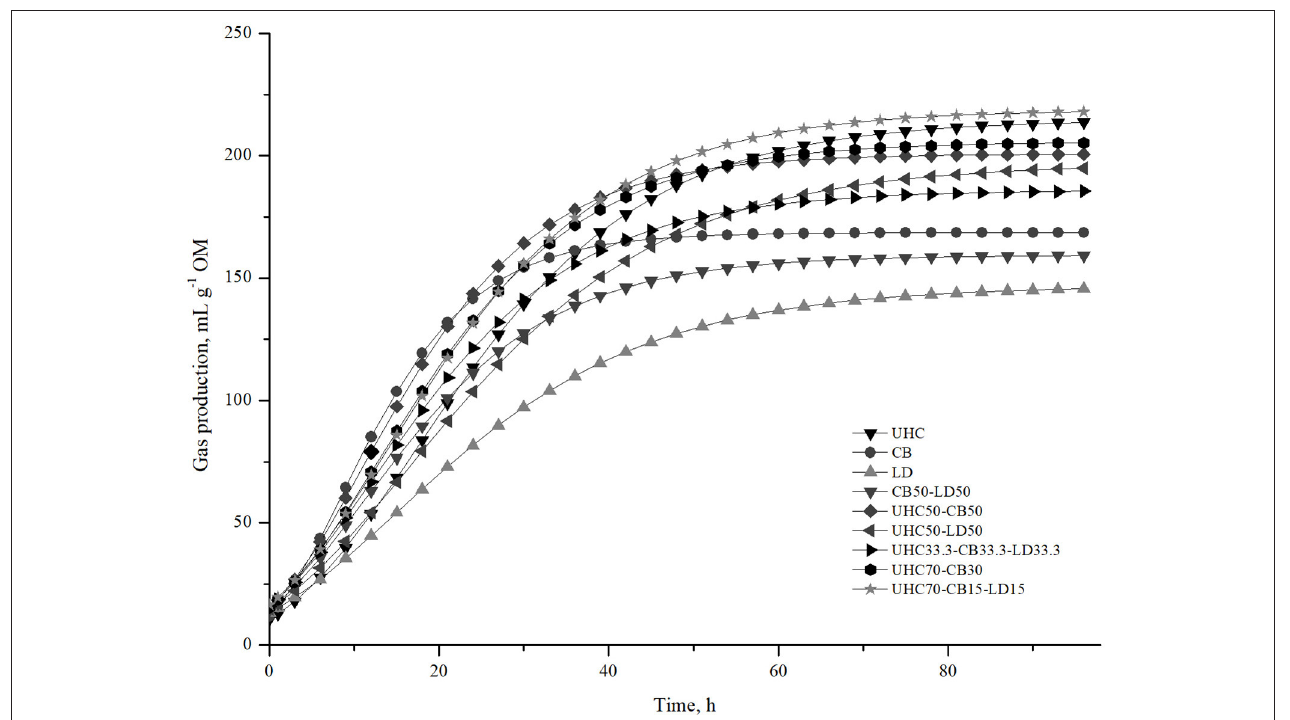
FIGURE 1 | Modeled mean accumulated gas production (mL g − 1 OM) for UHC, CB, LD, and 6 dietary mixtures. UHC, Cayman 100%; CB, Canavalia 100%; LD , Leucaena 100%; CB50LD50, Canavalia 50% + Leucaena 50%; UHC50CB50, Cayman 50% + Canavalia 50%; UHC50LD50, Cayman 50% + Leucaena 50%; UHC33.3CB33.3LD33.3, Cayman 33.3% + Canavalia 33.3% + Leucaena 33.3%; UHC70CB30, Cayman 70% + Canavalia 30%; UHC70CB15LD15, Cayman 70% + Canavalia 15% + Leucaena